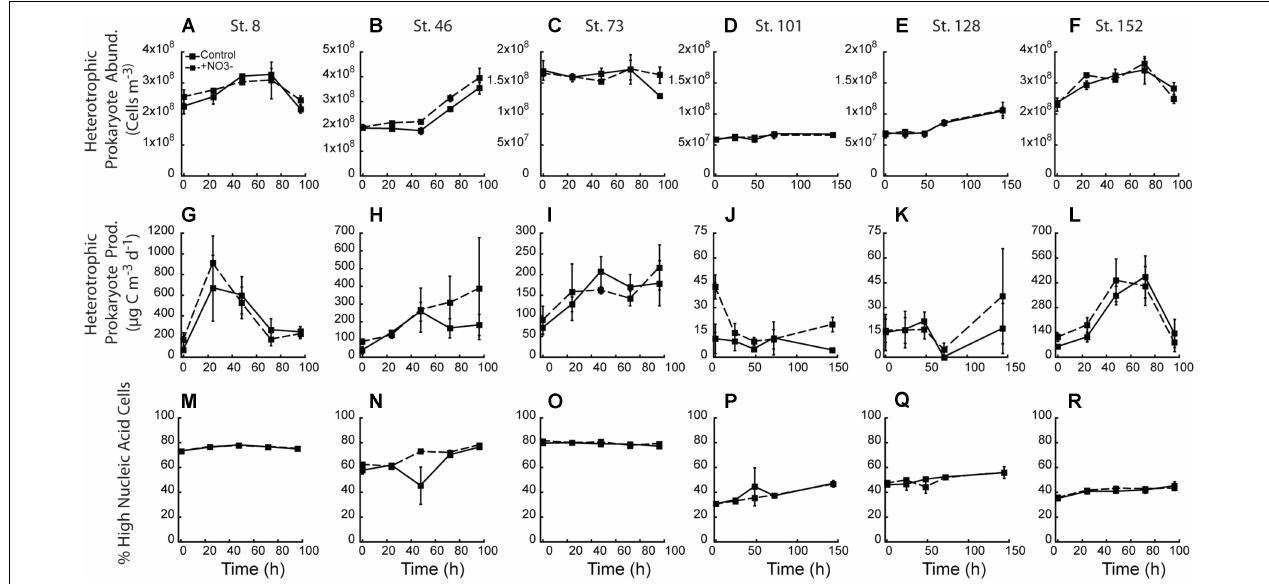
FIGURE 8 | Heterotrophic prokaryotic abundance (A–F) , heterotrophic prokaryotic production (G–L) , and percent of heterotrophic prokaryotic abundance comprised by high nucleic acid (HNA) cells (M–R) in the NO 3 − addition experiments.